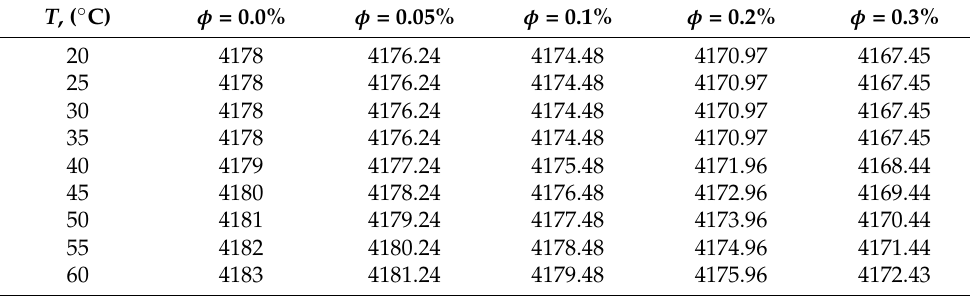
Table 5. Specific heat of hybrid